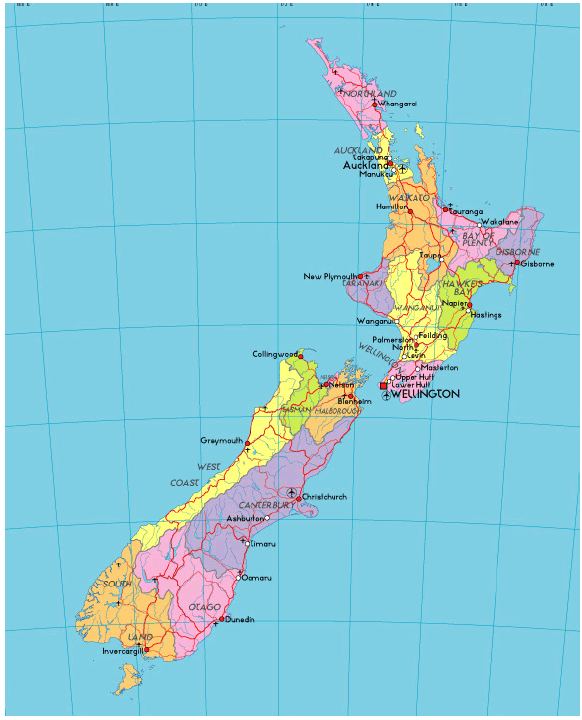
Figure 1. Regions of Aotearoa, New Zealand 1